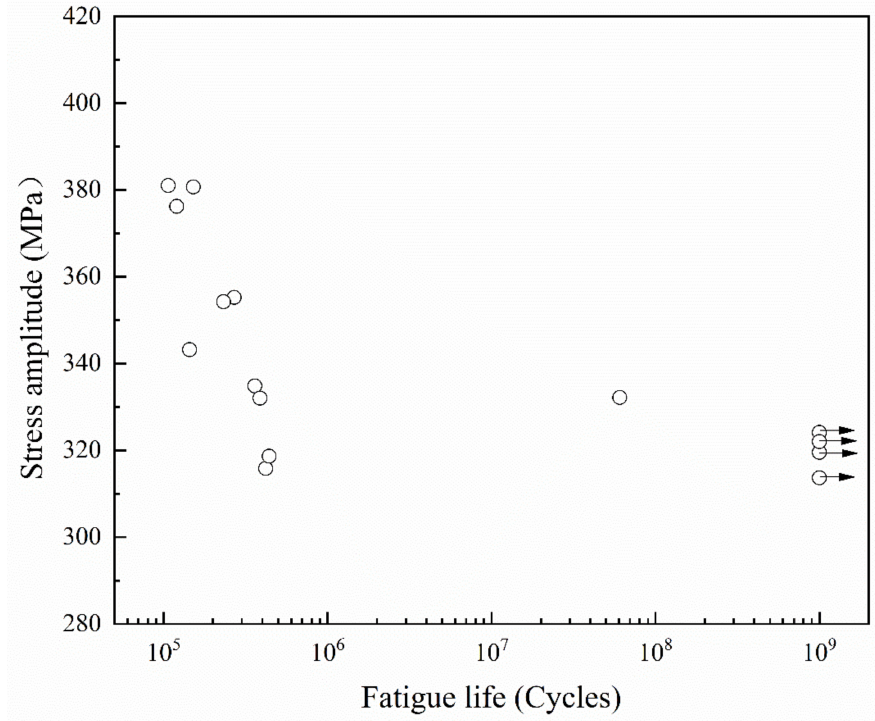
Figure 3. Fatigue results of ST 316L